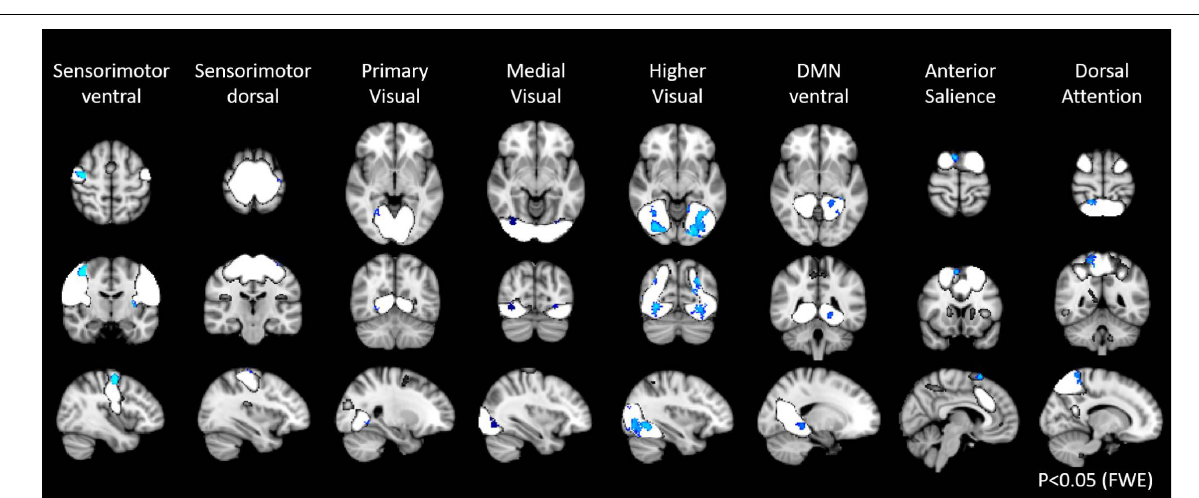
is consistent with many previous studies (Good et al.,